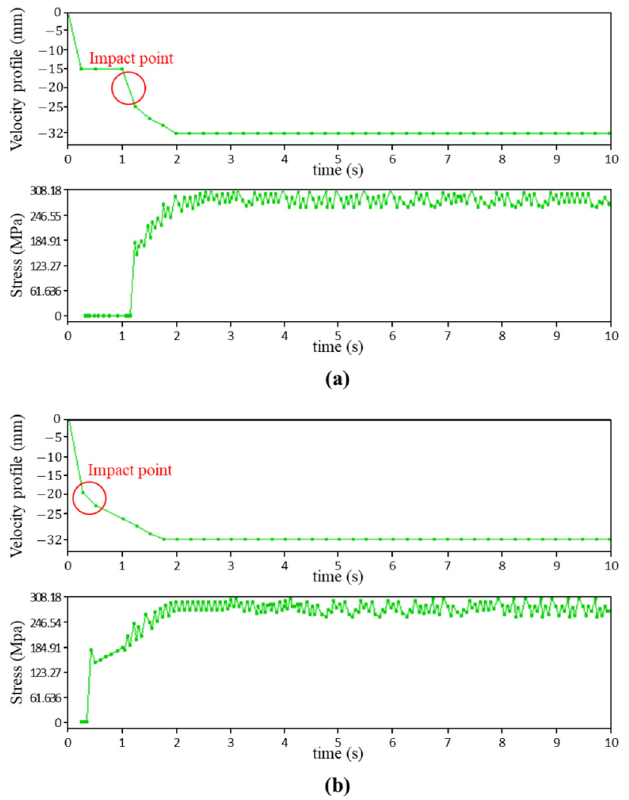
Figure 10. Stress distribution when roller descends according to curved velocity profile. Graphs of velocity profile of upper roller and steel plate stress when descending velocities are ( a ) 40 mm/s and ( b ) 20 mm/s at moment of impact.